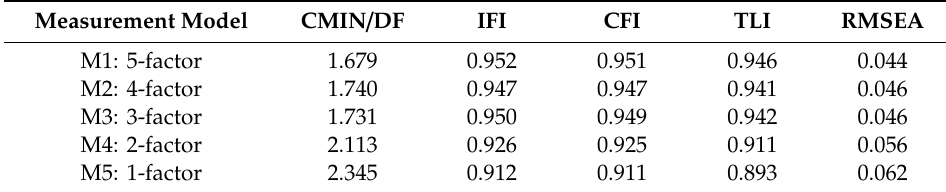
Table 1. Results of confirmatory factor